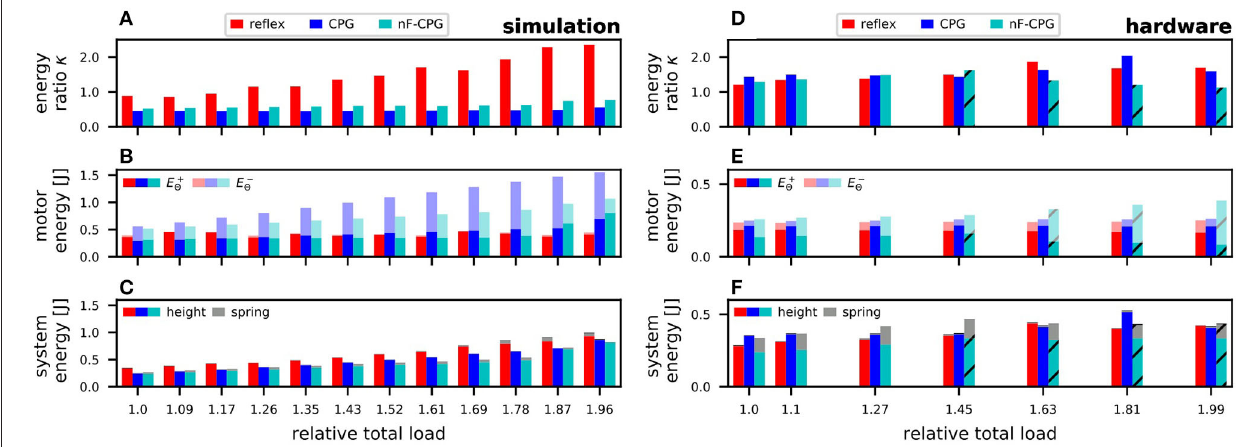
FIGURE 6 | Comparison of the energies and their ratios to judge the energy efficiency of the different controllers. Results are shown for the tested load conditions in simulations (A–C) and corresponding hardware setup (D–F) . (A,D) The energy ratio κ quantifies the controllers’ ability to efficiently add motor energy to the mechanical system. In the simulations, the reflex outperformed both CPGs, while in the hardware similar results were obtained. (B,E) The effective energy generated by the motor E + θ was mainly constant while the different controllers appeared to “lose” a varying proportion of motor energy ( E − θ ), especially in the simulations. (C,F) The internal system energy was mainly dependent on the relative jump height. Only for the nF-CPG in the experiment did a higher proportion relate to spring deflection (gray). The x-ticks indicate the total system mass relative to the initial mass without load, with the first tick having no load attached. The striped bars indicate trials in which the mechanical system could not hop